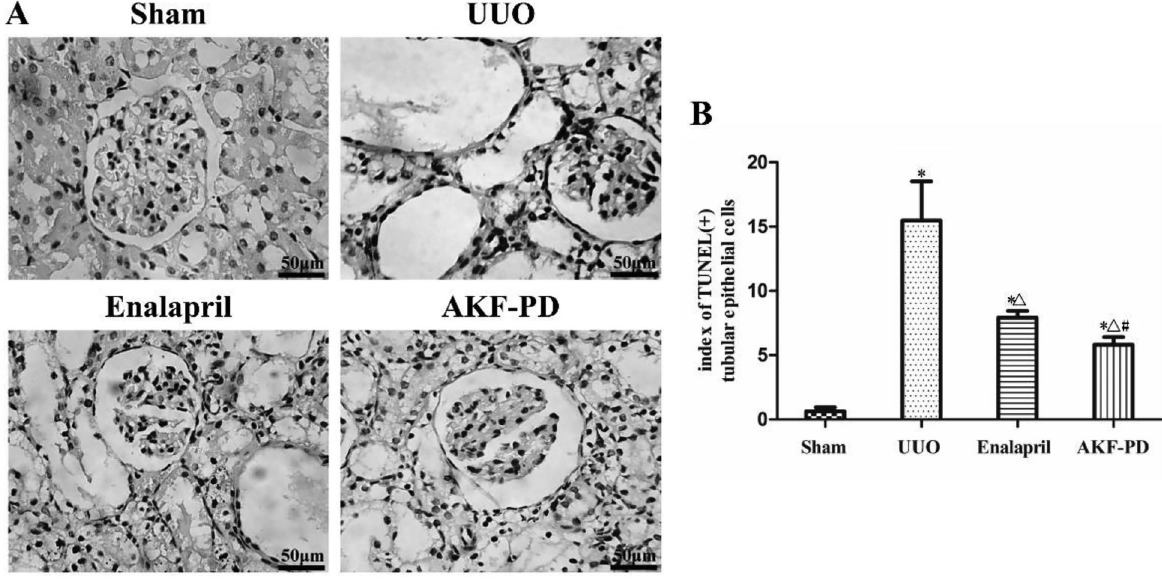
Figure 4. Fluorofenidone (AKF-PD) reduced the number of apoptotic renal tubular epithelial cells in the unilateral urinary obstruction (UUO) group. A , TUNEL staining results of kidney tissues in the sham, UUO, UUO + enalapril, and UUO + AKF-PD groups (400 (cid:3) magni fi cation, bar: 50 m m). B , Semiquantitative analysis results of the number of apoptotic tubular epithelial cells. Data are reported as means ± SD. *P o 0.05 vs the sham group. W P o 0.05 vs the UUO group. # P o 0.05 vs the UUO + enalapril group